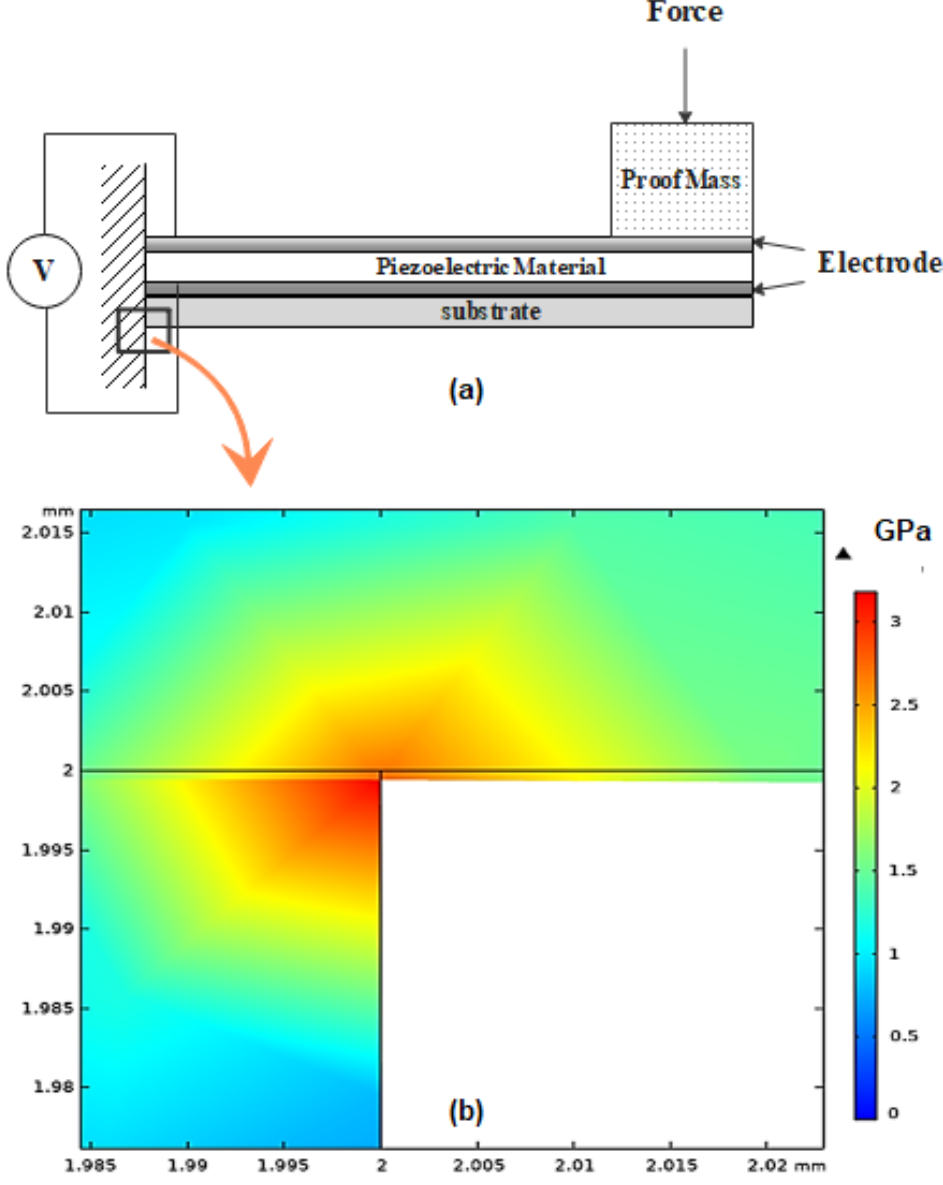
Figure 3. PEH cross sectional schematic and FEM analysis: ( a ) Cross sectional schematic of the PEH. ( b ) Zoom view of maximum mechanical stress distribution area obtained from FEM in the cantilever beam at a cc = 2